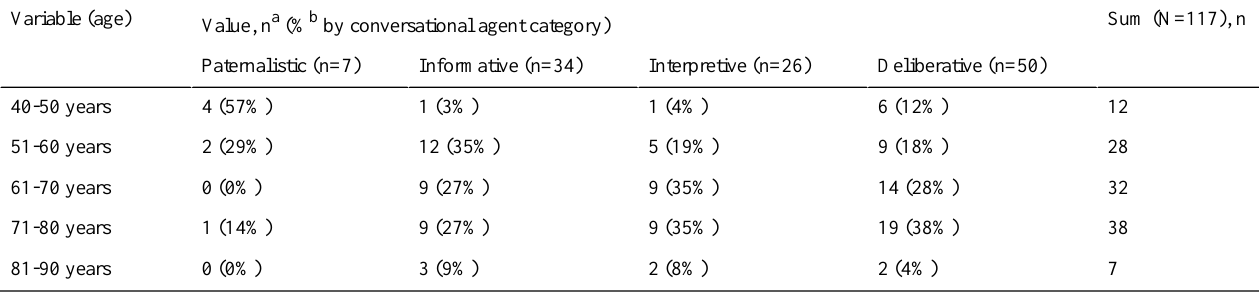
Table 3. Conversational agent preferences by age.